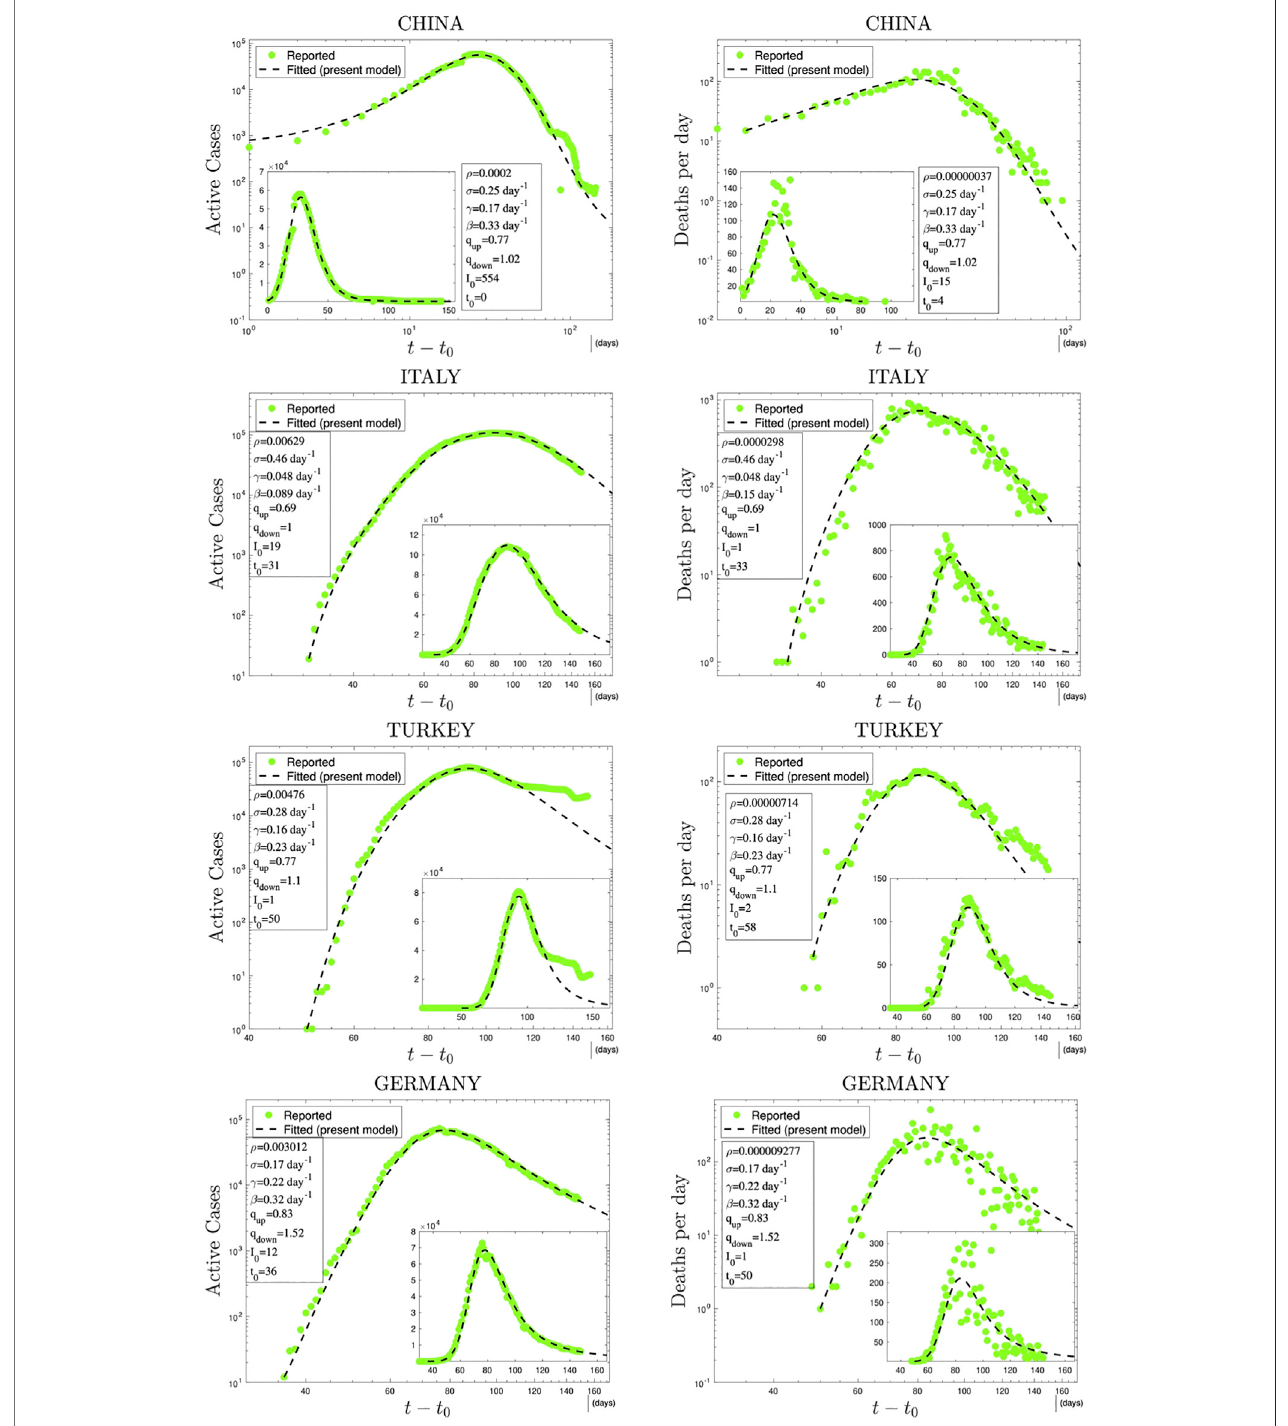
FIGURE3| TimeevolutionofavailabledataforCOVID-19numbersofactivecases(probablyunder-reportedinmostcases)anddeathsperday[27]andtheir(linear scale) Least Squares Method fi ttings with N eff I ( t ) from the q -SEIR model; ρ (cid:2) N eff / N , where N is the population of the country. Notice that, (i) by convention, t 0 (cid:2) 0 for China; (ii) parameters such as ρ N are particularly relevant for sanitary-epidemiological decisions, and, as it is natural, ρ ( deaths ) ≪ ρ ( active ) for any given country; (iii) for anygivencountry,thevaluesof ( q up , q down ) arethesameforbothcurvesofactivecasesandofdeaths;(iv)thedatesofthepeaksoftheactivecasesanddeathsper day do not necessarily coincide; (v) the values that emerge for β / c ( reproduction number or growth rate ), 1 / β ( exposition time ), 1 / c ( recovering time ), and 1 / σ ( incubation time ) are consistent with those currently indicated in the literature [21 – 25]; (vi) we considered all the data reported until June 13, excluding some very initial transients or sudden anomalous discrepancies (e.g., in China, Turkey, and Brazil).